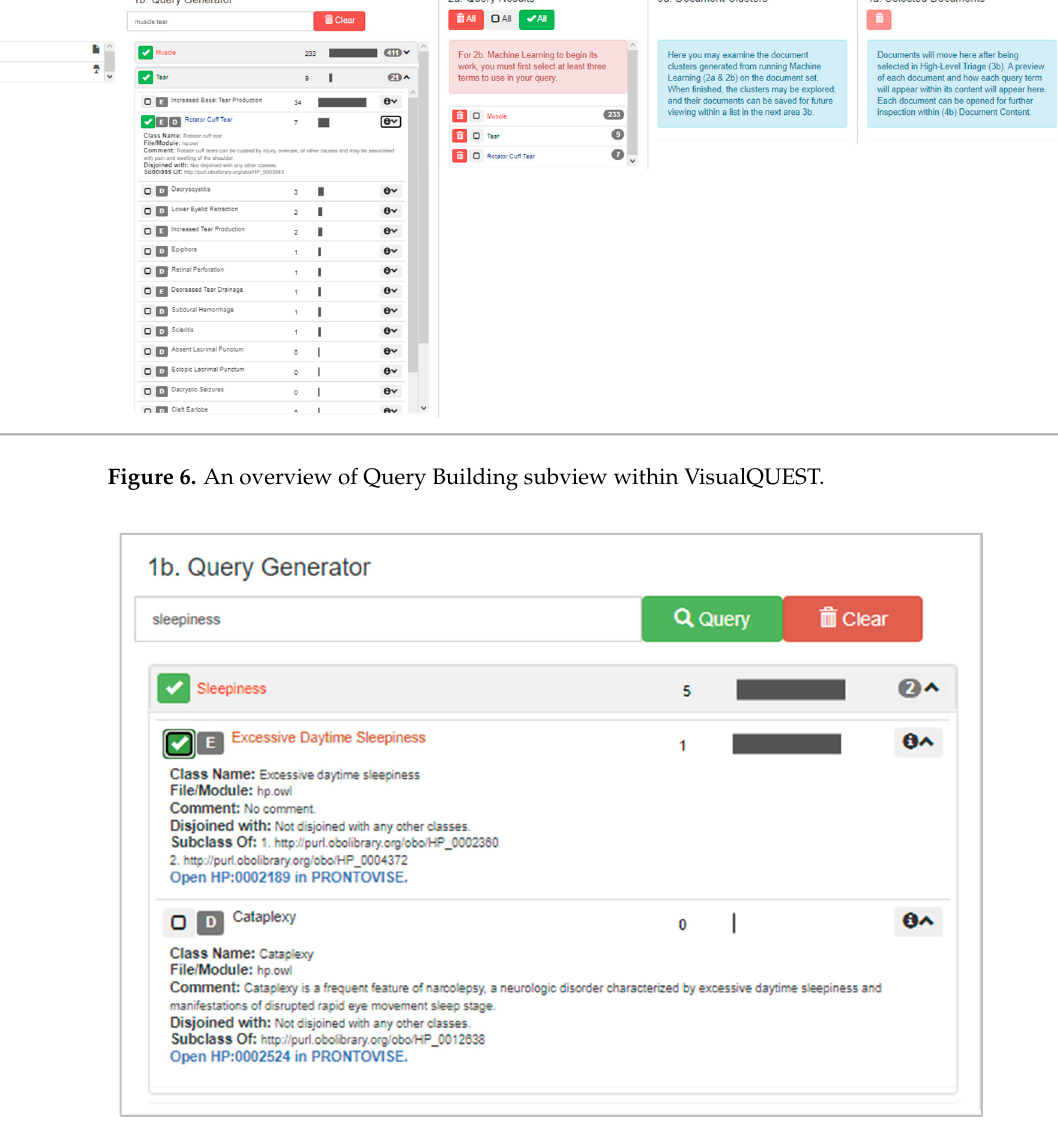
Figure 8. An overview of the Search subview within VisualQUEST. In this subview, users can control the formulation of search queries, encounter sensi- tivity-encoded previews of the formulation, and initialize the search on the full document set (DC4). In the Search subview, a list allows users to manage query items, including insertion into the search formulation (DC11). After at least one query item has been se- lected, a preview of the current search formulation is activated (Figure 9).